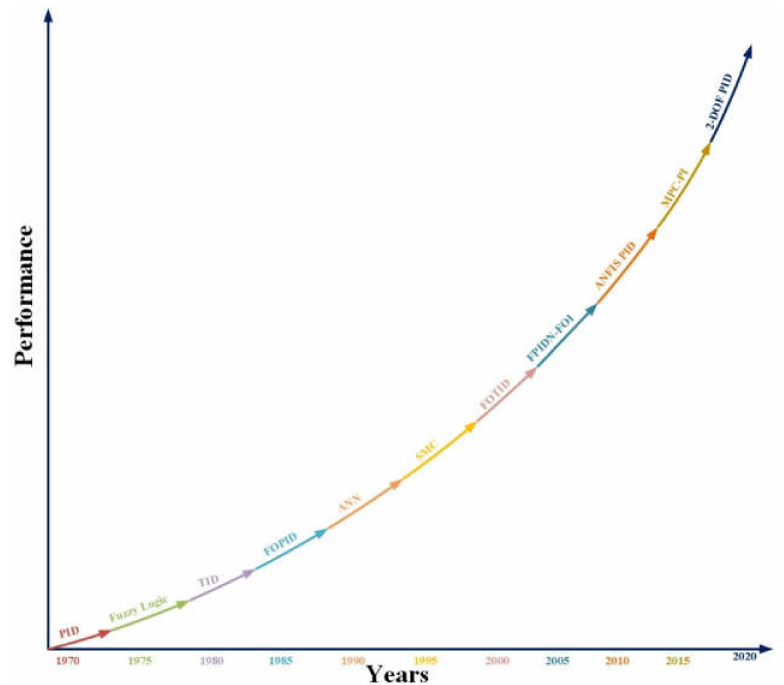
Figure 16. Roadmap of LFC